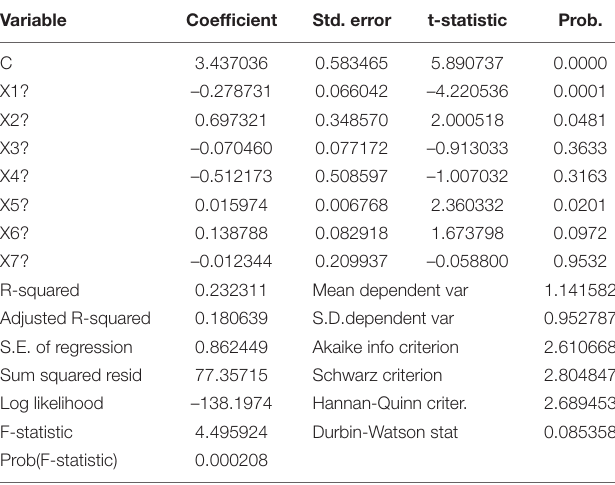
TABLE 4 | Regression results of mixed estimation